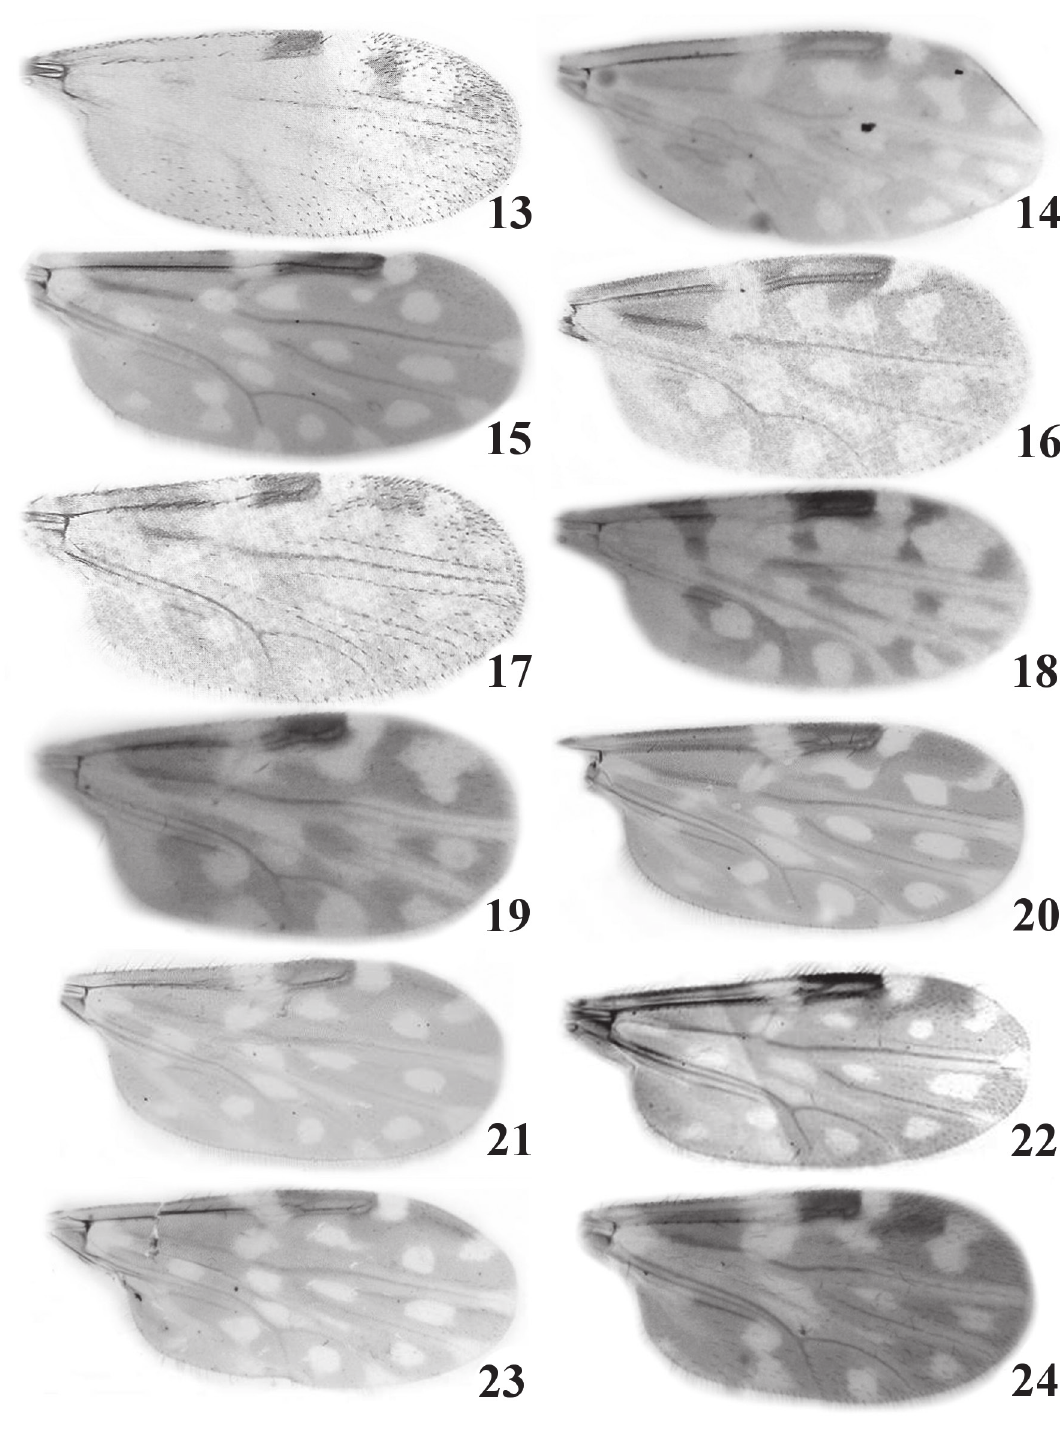
Figures 13-24 - Wing photograph of Culicoides reticulatus species group. 13. C. kuscheli. 14. C. lanei. 15. C.